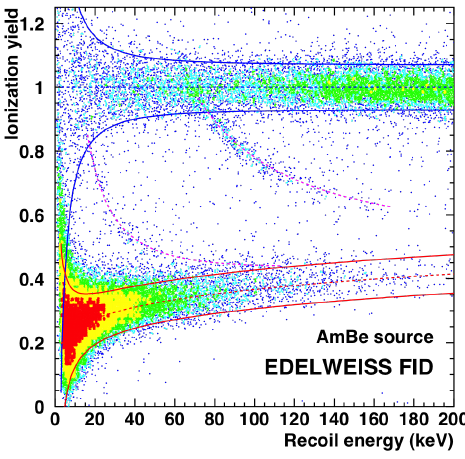
Figure 39: Ionization yield versus recoil energy for data taken with an AmBe neutron calibration source illustrating clear separation between electron recoils with yield ∼ 1 and nuclear recoils with yield ∼ 0.3. Blue lines indicate the 90% C.L. for elec- tron recoils, red lines indicate the 90% C.L. for nuclear recoils, and the magenta lines illustrate the inelastic scattering of neutrons on the first (13.28 keV) and third (68.75 keV) excited state of 73 Ge. Adapted from [ 64 ]